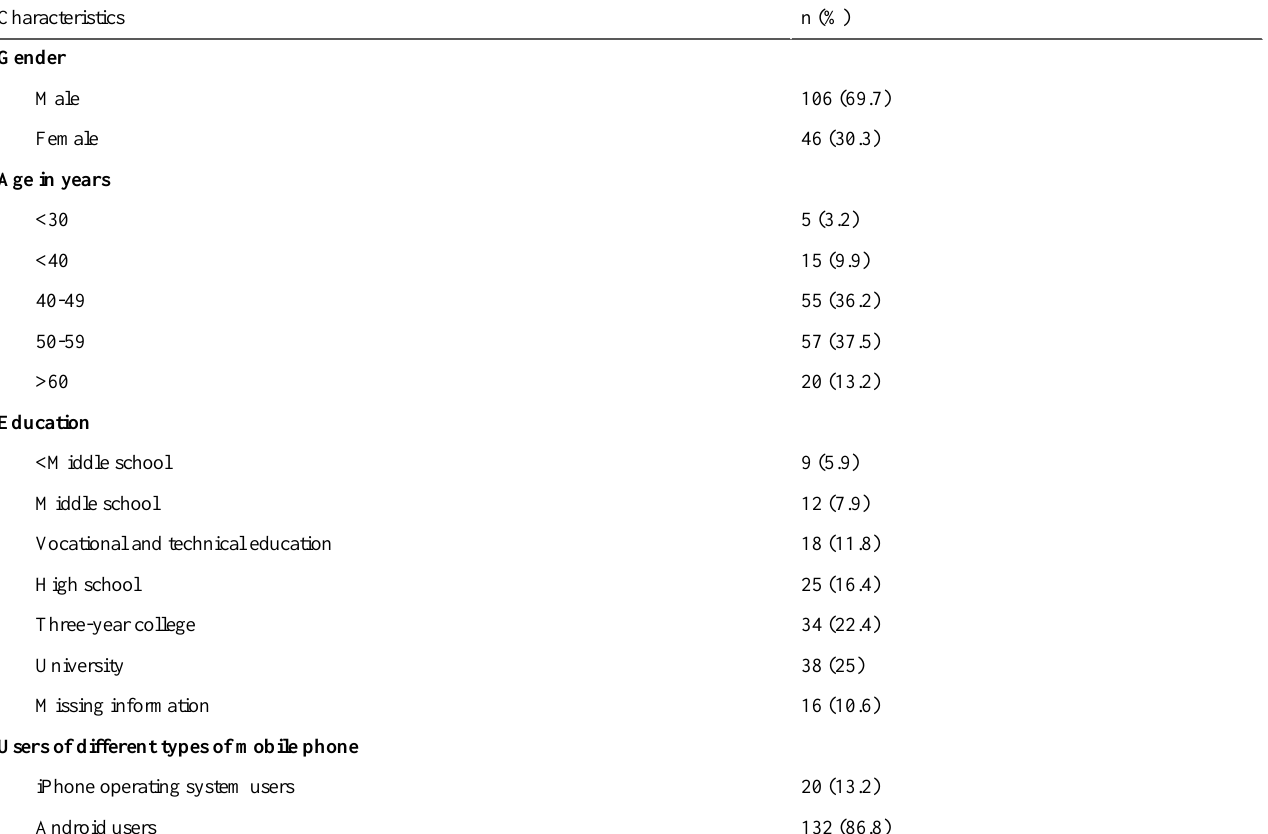
Table 2. Demographics of the participating